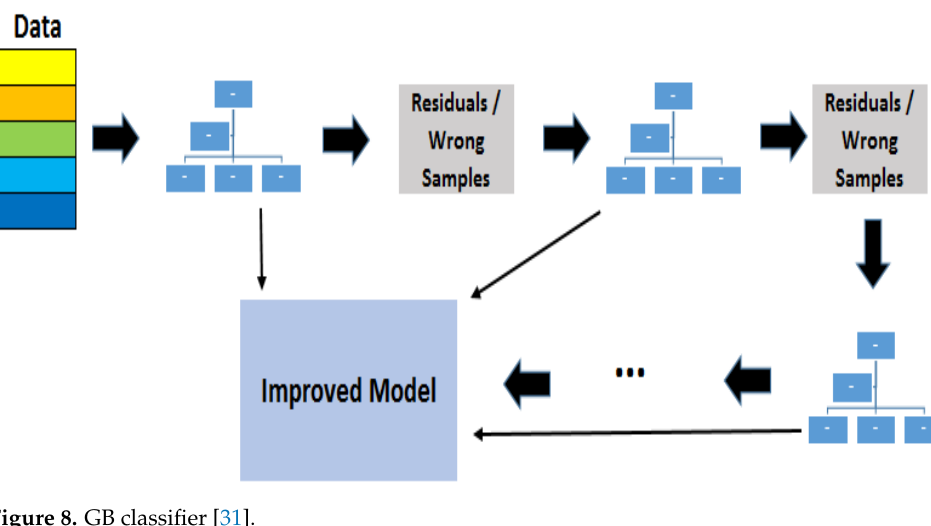
Figure 8. GB classifier [31] .